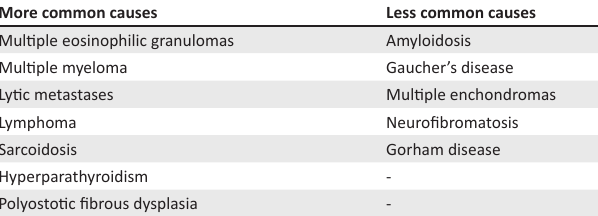
TABLE 1: Radiographic features of cystic angiomatosis of bone. Radiographic feature Axial and proximal appendicular skeleton affected. Well-circumscribed lytic lesions in the medullary cavity of bone. Round or oval shaped. Intact overlying cortex. Typically no periosteal reaction. Endosteal scalloping may be seen. Variable surrounding sclerosis. Honeycombed or lattice pattern described.